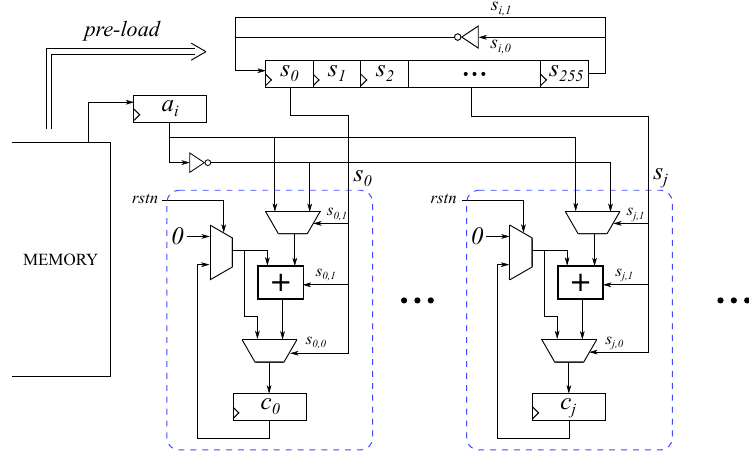
Figure 5: Parallel architecture of Sable polynomial